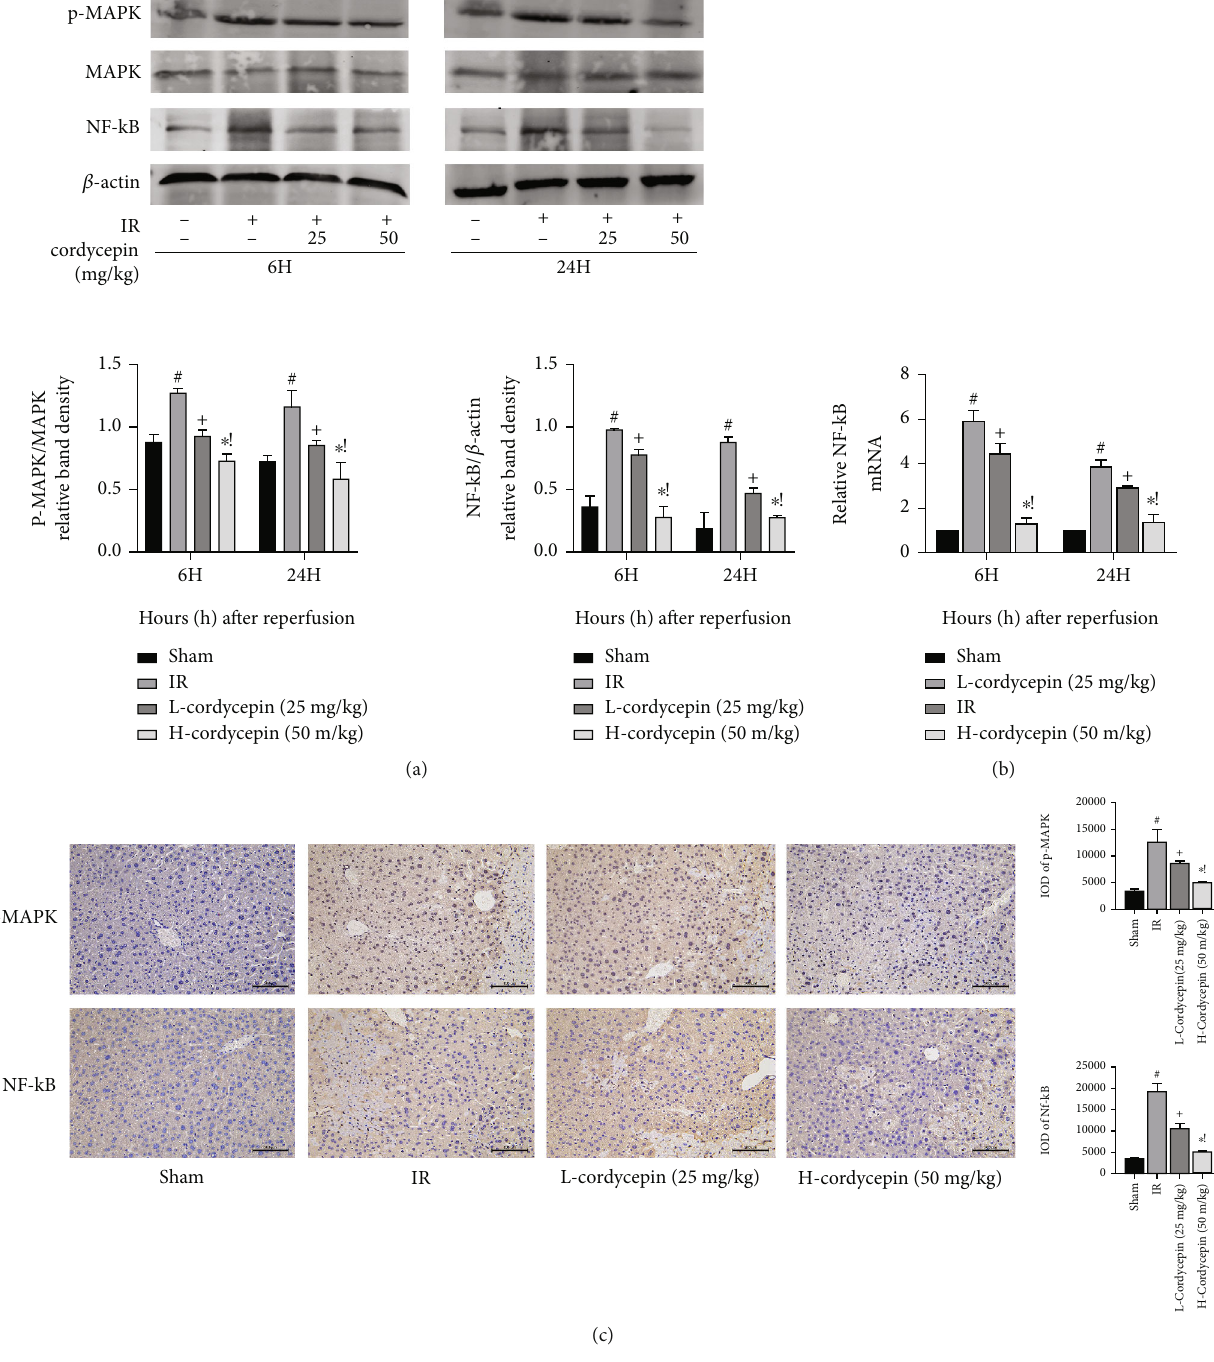
Figure 5: The protective e ff ect of cordycepin on HIRI in mice was related to MAPK/NF- κ B signaling pathway. Note: (a) western blot analysis of MAPK, p-MAPK, and NF- κ B protein levels. (b) Relative NF- κ B levels were determined by qRT-PCR. (c) p-MAPK and NF- κ B protein expressions in liver tissues after reperfusion are shown by immunohistochemical staining ( × 200). The evaluations were made by the Image-Pro Plus 6.0 software to calculate the IOD of the positive staining area. Data are presented as mean ± SD ( n = 6 ; # p < 0 : 05 for IR vs. sham; + p < 0 : 05 for L-cordycepin (25 mg/kg) vs. IR; ∗ p < 0 : 05 for H-cordycepin (50 mg/kg) vs. IR; ! p < 0 : 05 for L-cordycepin (25 mg/kg) vs. H-cordycepin (50